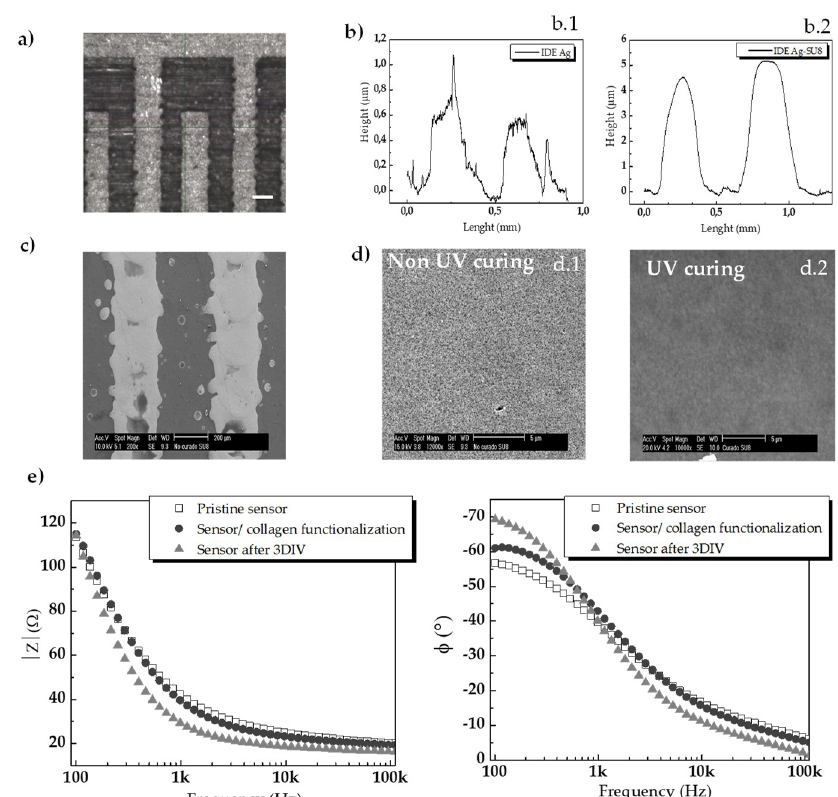
Figure 3. ( a ) Optical micrography of the inkjet-printed sensors (scale bar 100 μm). ( b ) Surface profilometry of the two continuous inkjet-printed electrodes, revealing a thickness of a 0.6 μm for bare Ag electrodes ( b .1) and 4 μm for passivated electrodes ( b .2). ( c ) SEM micrography of the inkjet-printed sensor surface in a top view ( c .1, scale bar 200 μm). ( d ) The effect of UV curing on the SU-8 passivation layers showed an increase in the smoothness of the outmost layer. UV treated samples showed a smoother surface ( d.2 ) compared with non-treated samples ( d.1 ). ( e ) Electrical performance of pristine inkjet-printed sensors, sensors with collagen functionalization, and sensors after three days in vitro with HaCaT cell cultures. Magnitude of the impedance (left) and phase